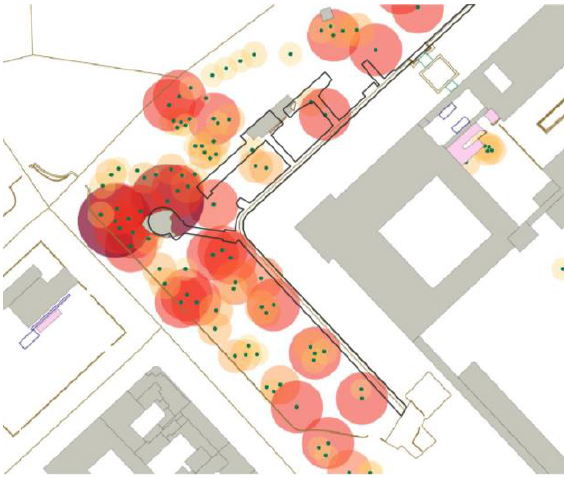
Figure 5. Relationship between the underground structure of the Ghirlanda and the trees system of the park First of all, it was necessary to insert the information about the surrounding vegetation in the GIS environment. The material, in shapefile format, was downloaded from a website of the municipality of Milan, R3 Trees. This is the database of the green areas of the city. From the Parco Sempione file, only the elements near the Castle have been considered. The latter does not have, as an attribute, indications on the depth of the root system but there was information relating to the genre and species of